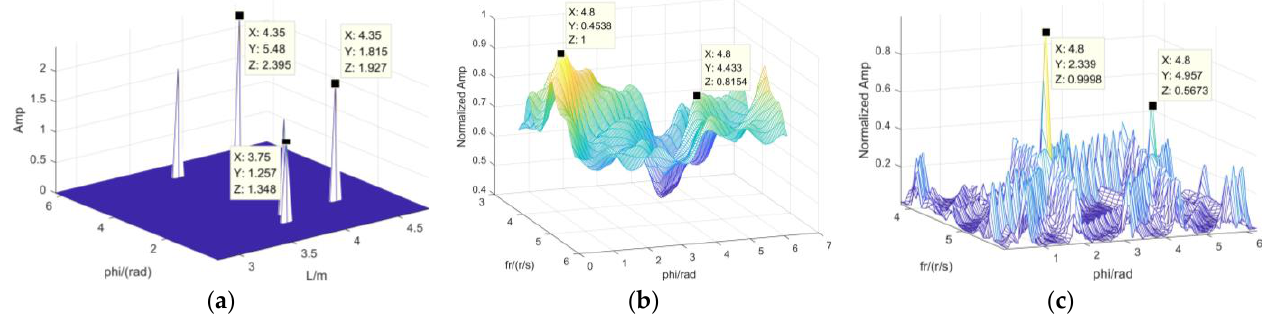
Figure 20. Processing results for the OMP, HT, and GLRT methods: ( a ) OMP method; ( b ) HT method; ( c ) GLRT method .